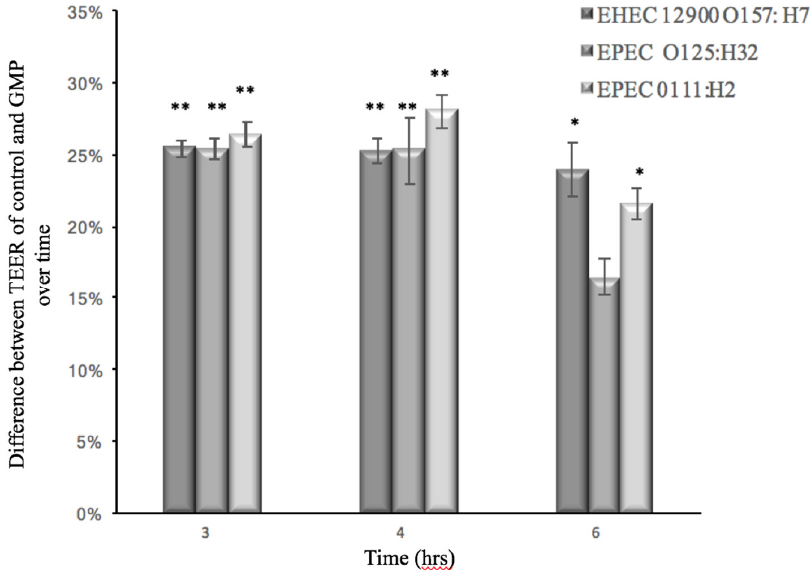
Figure 3. Percentage of prevention of reduction in Transepithelial Electrical Resistance (TEER) values of Caco ‐ 2 monolayers after infection with E. coli strains pretreated with GMP in comparison to untreated control (** p < 0.01 and * p < 0.05).